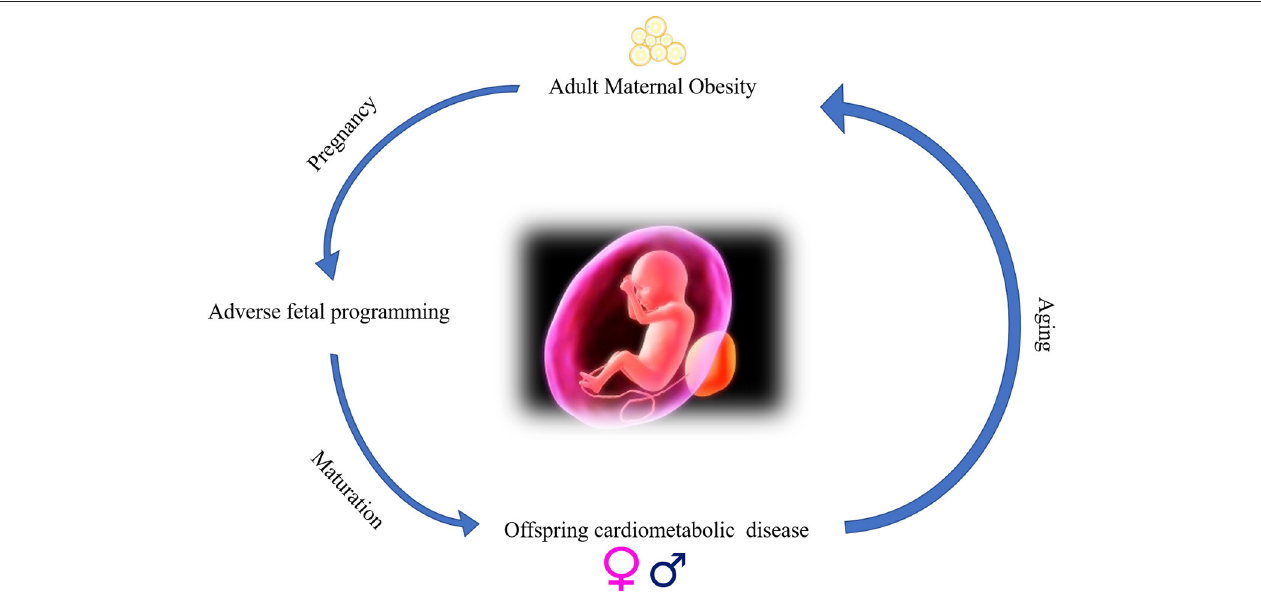
FIGURE 4 | Working hypothesis for effects of maternal obesity on fetal programming. A depiction of the in- utero effects of maternal obesity on offspring demonstrated by BPH5 mouse model. Adverse fetal programming attributing to low birth weight and early accelerated catch up growth. Offspring cardiometabolic disease accrediting to increased adiposity and cardiomegaly found in this study. Image made with Creative Commons.